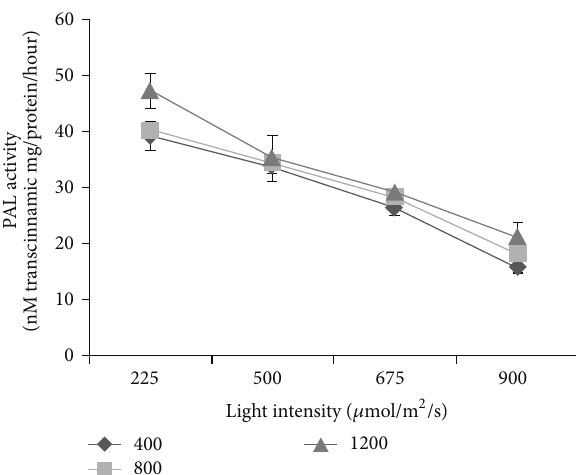
Figure 1: Interaction effects of CO 2 and irradiance on PAL activity of Labisia pumila ; 𝑁 = 21 . Bars represent standard error of differences between means (SEM).